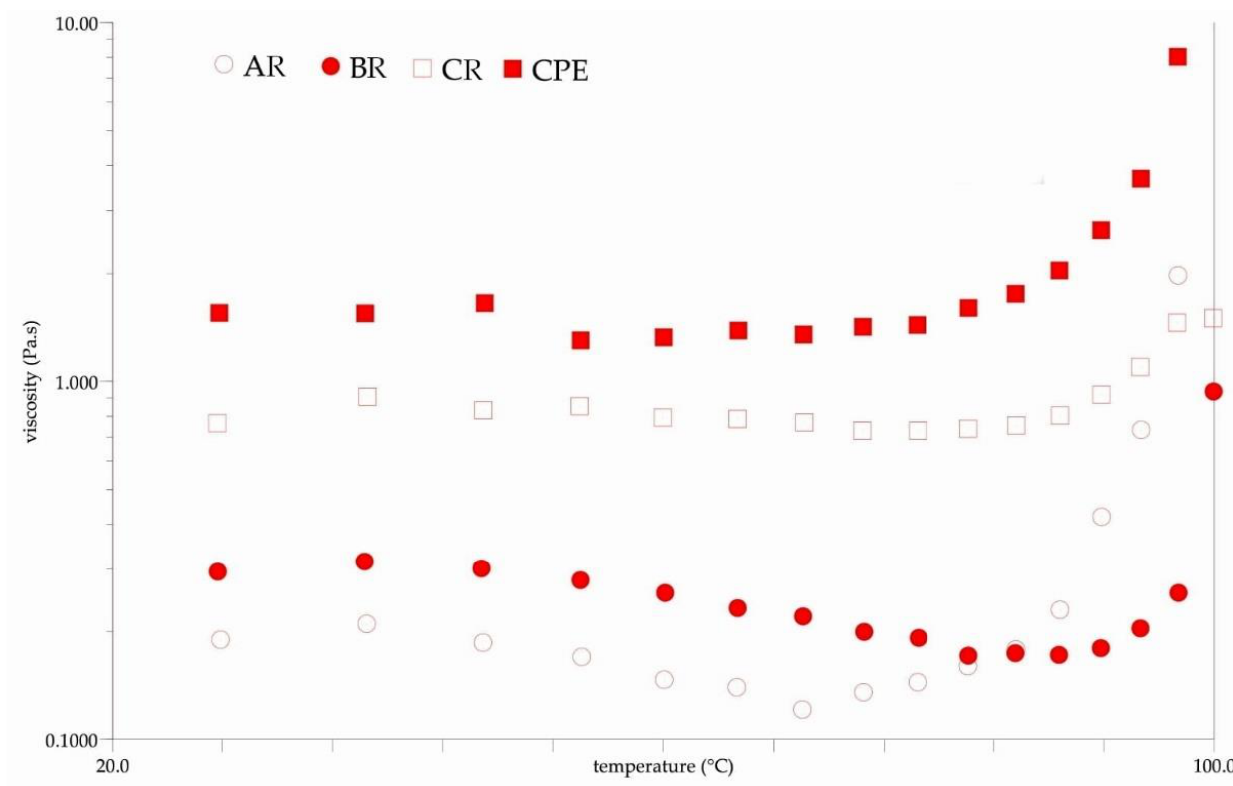
Figure 5. Rheograms of CPE and reconstituted samples. ( A ) — Changes of viscosity. ( B ) — Changes of shear stress. CPE: Camelina Press Cake Extract; AR: reconstituted sample spray-dried at 140 °C; BR: reconstituted sample spray-dried at 160 °C; CR: reconstituted sample spray-dried at 180 °C.